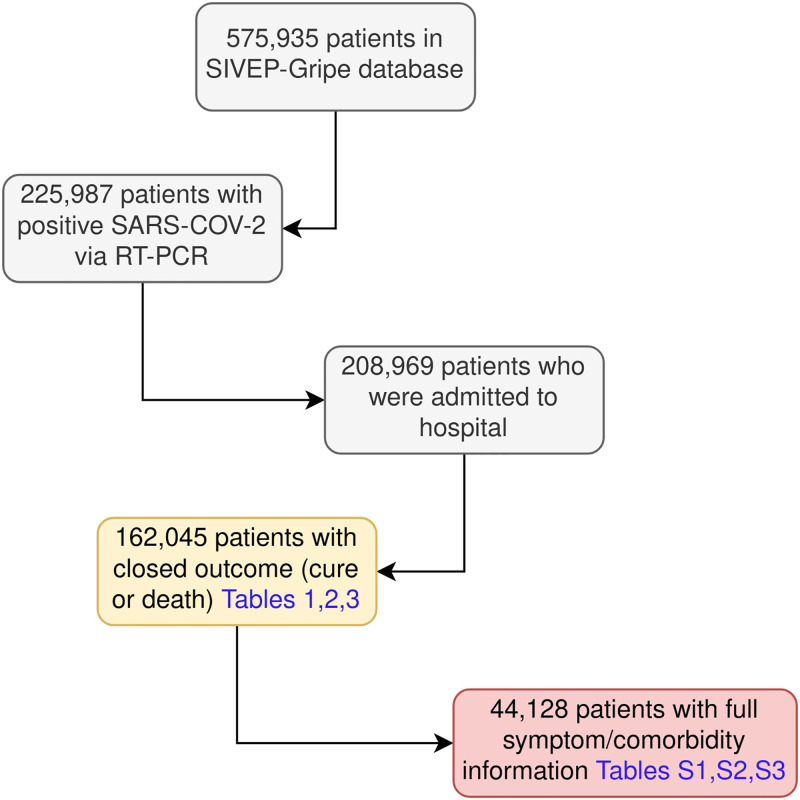
Flowchart of SIVEP-Gripe data used in the study.